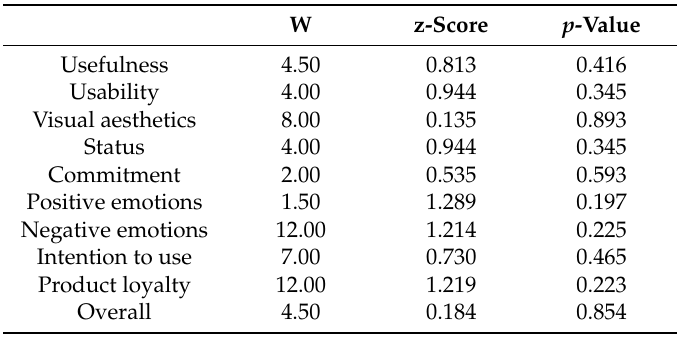
Table 21. Test for correlation between design type and meCUE